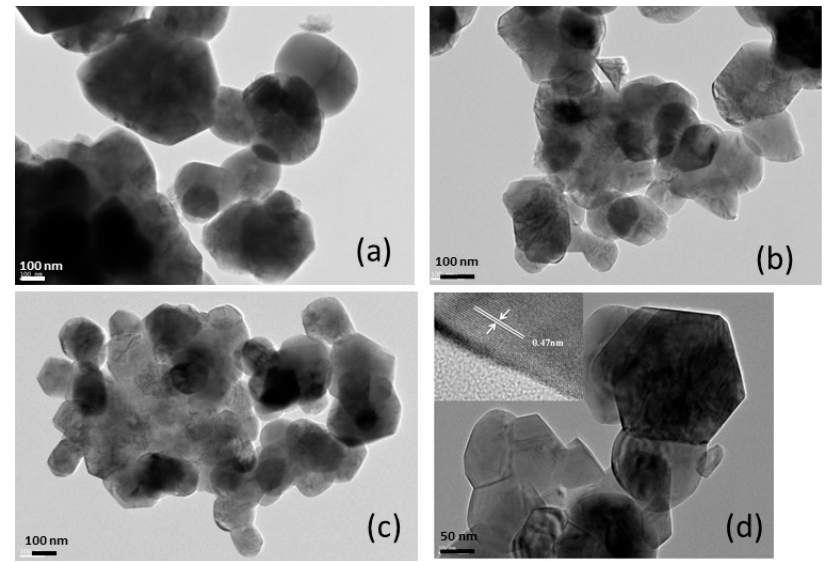
Figure 20. HRTEM images of Li-rich cathode materials y Li 2 MnO 3 •(1 − y )(LiNi 0.5 Mn 0.5 O 2 ). ( a ) y = 0.0 (LiNi 0.5 Mn 0.5 O 2 ); ( b ) y = 0.3 (Li 1.134 Ni 0.3 Mn 0.566 O 2 ); ( c ) y = 0.5 (Li 1.2 Ni 0.2 Mn 0.6 O 2 ); ( d ) image